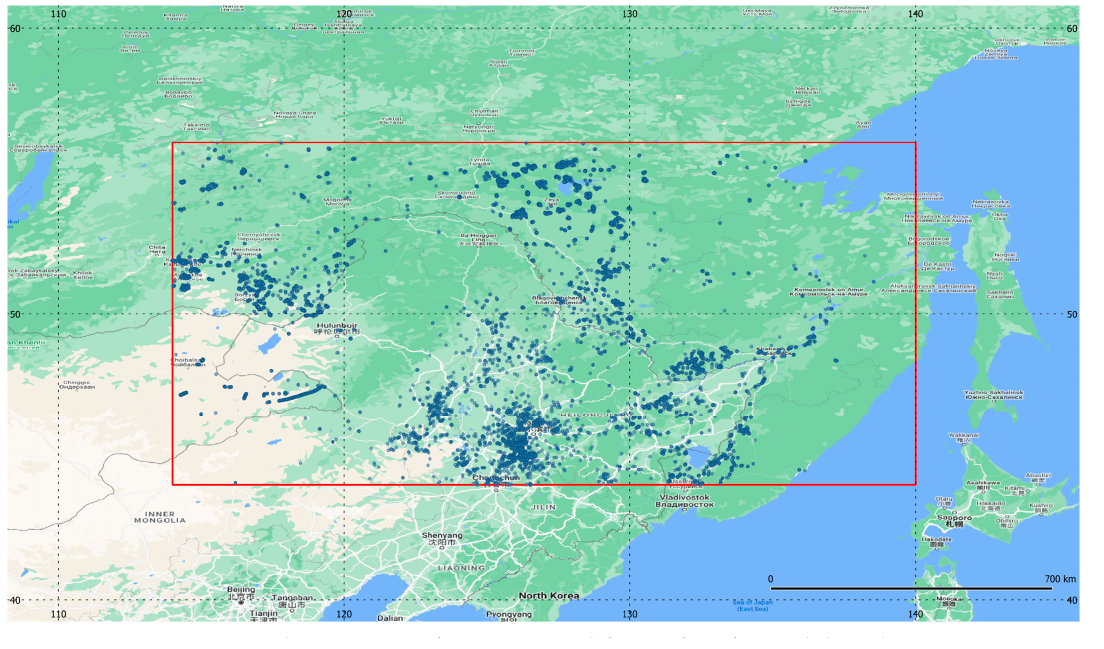
Figure 10. Region of Interest (ROI) with frequent forest fires in Khabarovsk Krai (NW corner coordinates: 56N 114E; SE corner: 44S 140E). VNF detections used in this study are shown with blue circles. Background is from Google Maps.